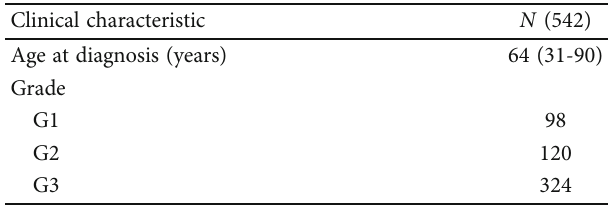
Table 1: Characteristics of patients with renal clear cell carcinoma on The Cancer Genome